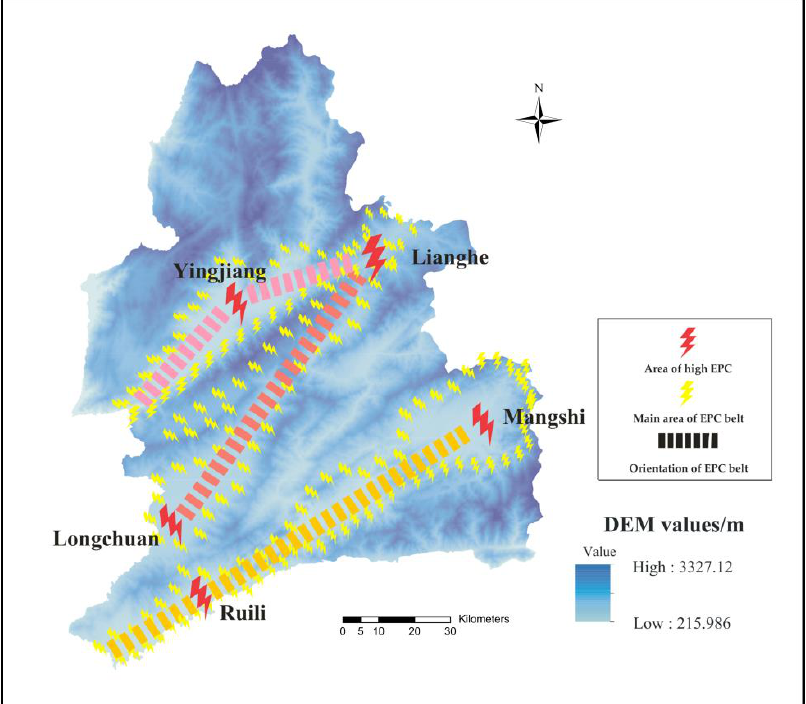
Figure 10. REPC belt results.